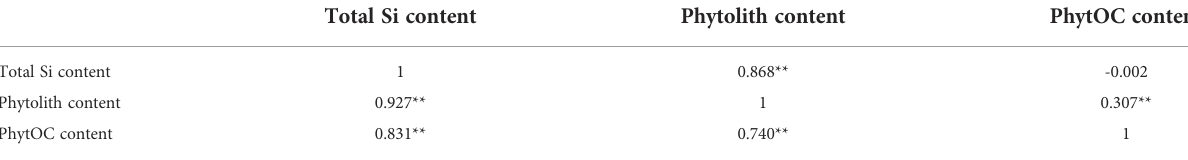
TABLE 3 Correlations among total Si, phytolith, and PhytOC contents of Fagopyrum